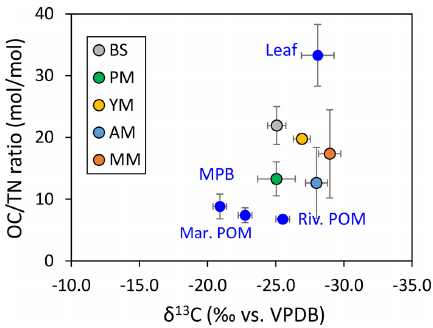
Figure 6. Source identification of sedimentary organic matter using end-member carbon stable isotope ratio and OC:TN.